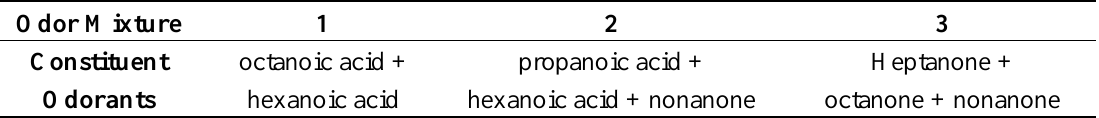
Table 2. Constituent odorants of each odor mixture.